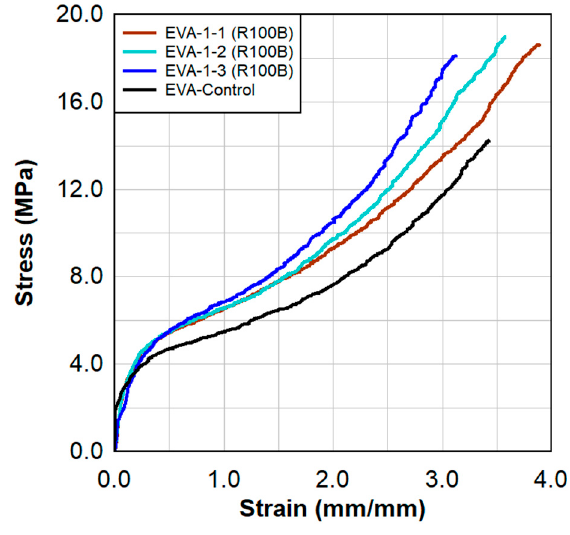
Figure 7. Static tensile test results for the EVA − 1 specimens and a comparison to the virgin EVA material.